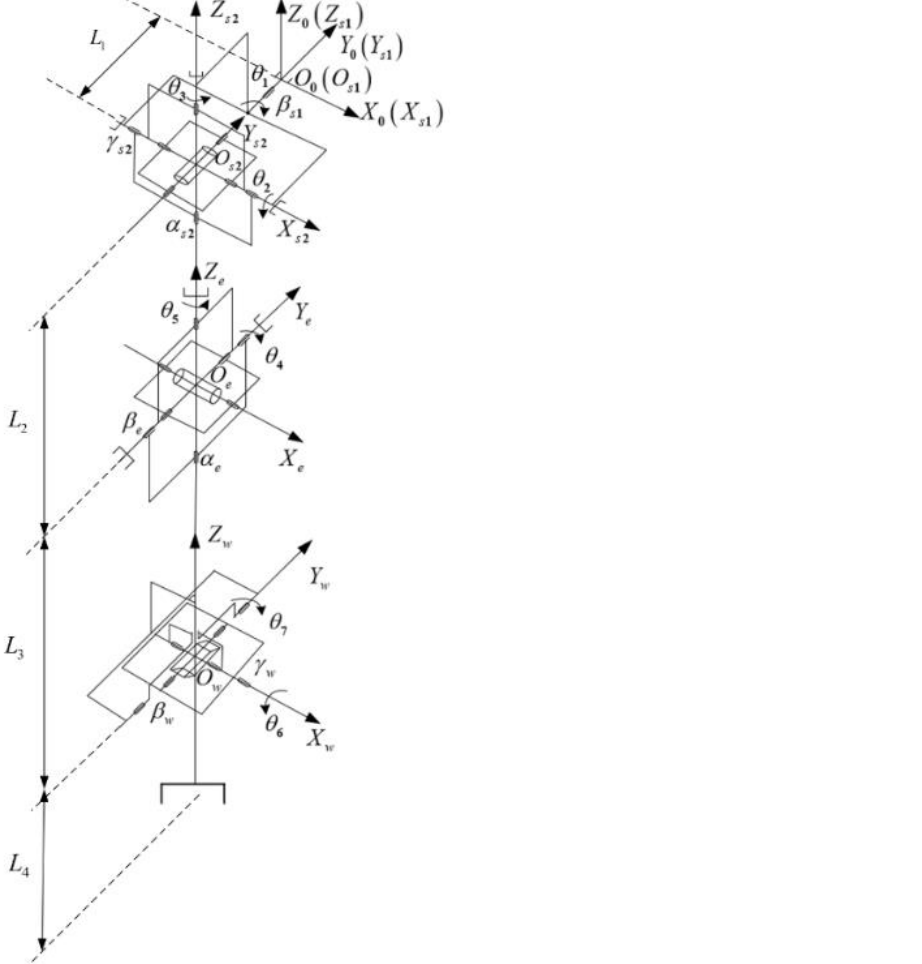
Figure A1. The mechanism diagram of the humanoid manipulator.